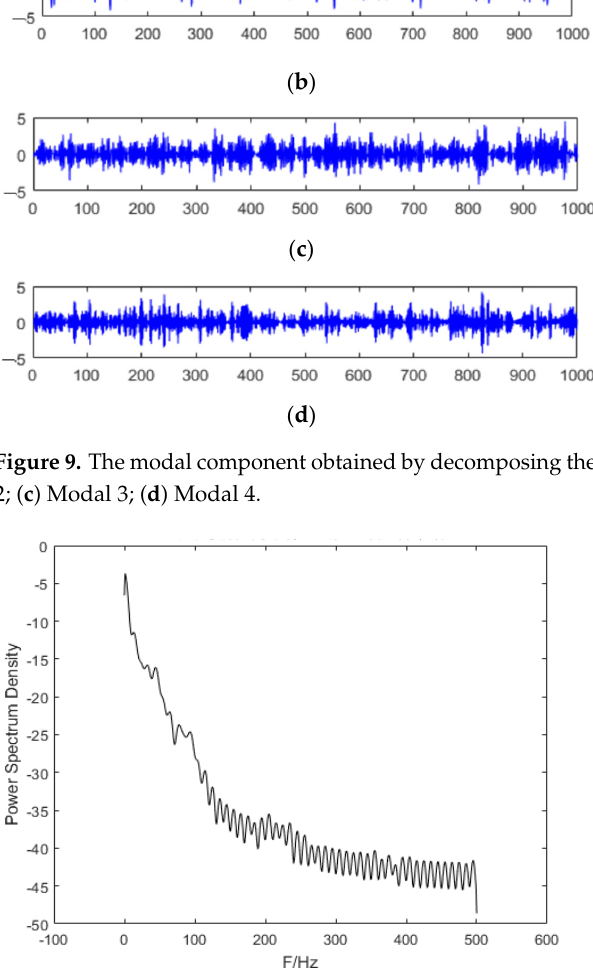
parameter, and decomposition.